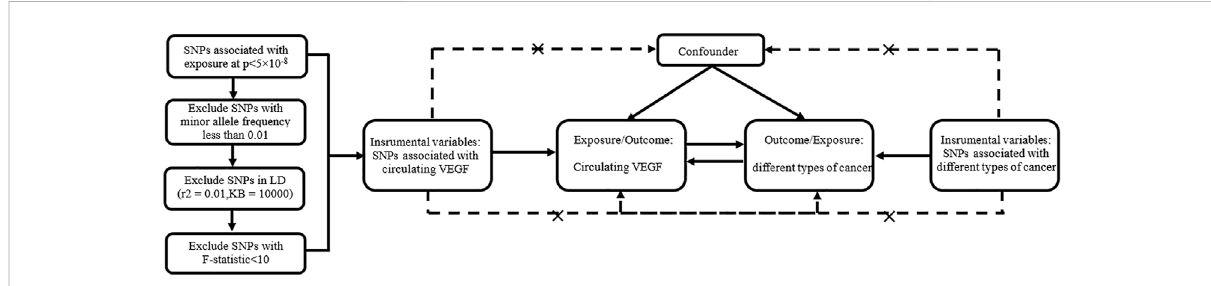
Bidirectional Mendelian randomized study design between circulating VEGF and different types of